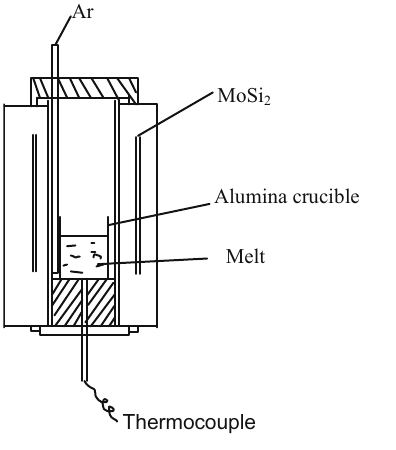
Figure 3: Diagram of experimental